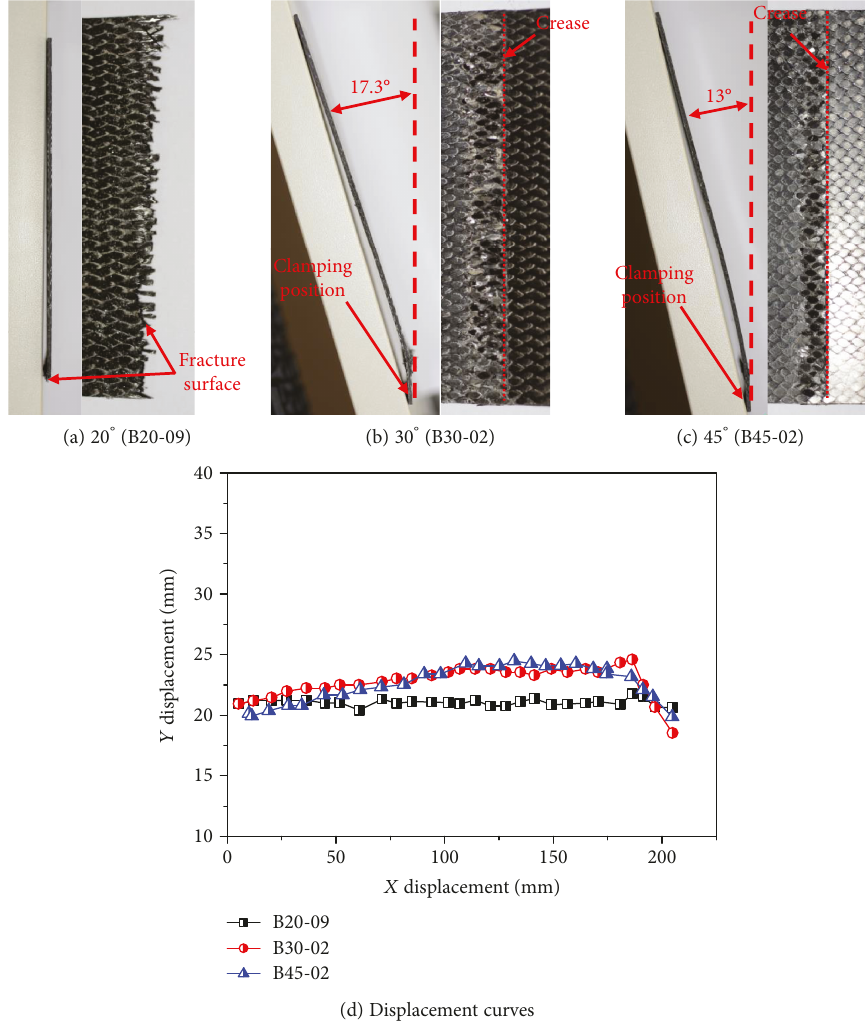
Figure 13: Final deformation and damage on braided target of di ff erent braiding angles.